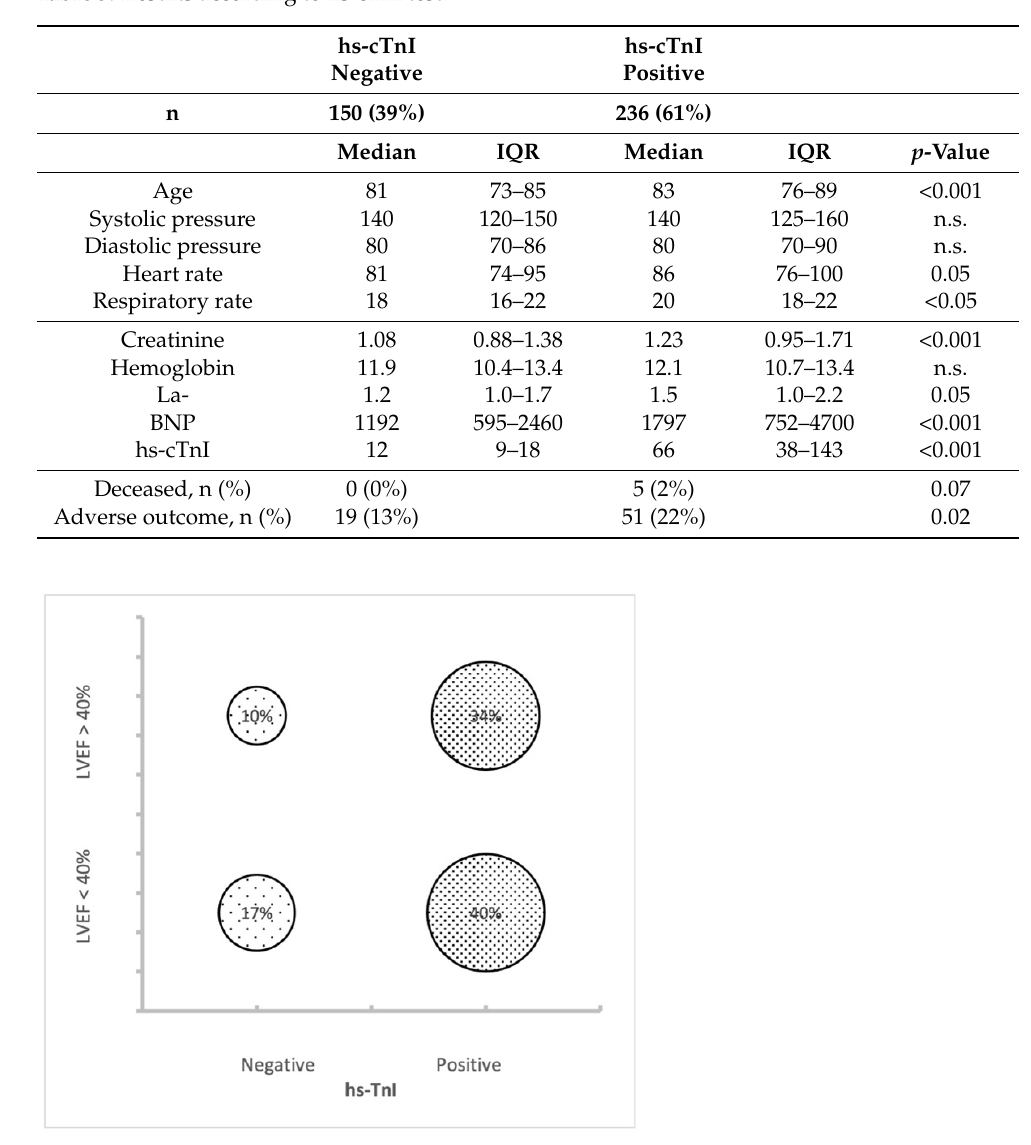
Figure 2. Distribution of patients with an adverse outcome divided for LVEF and hs-cTnI results.